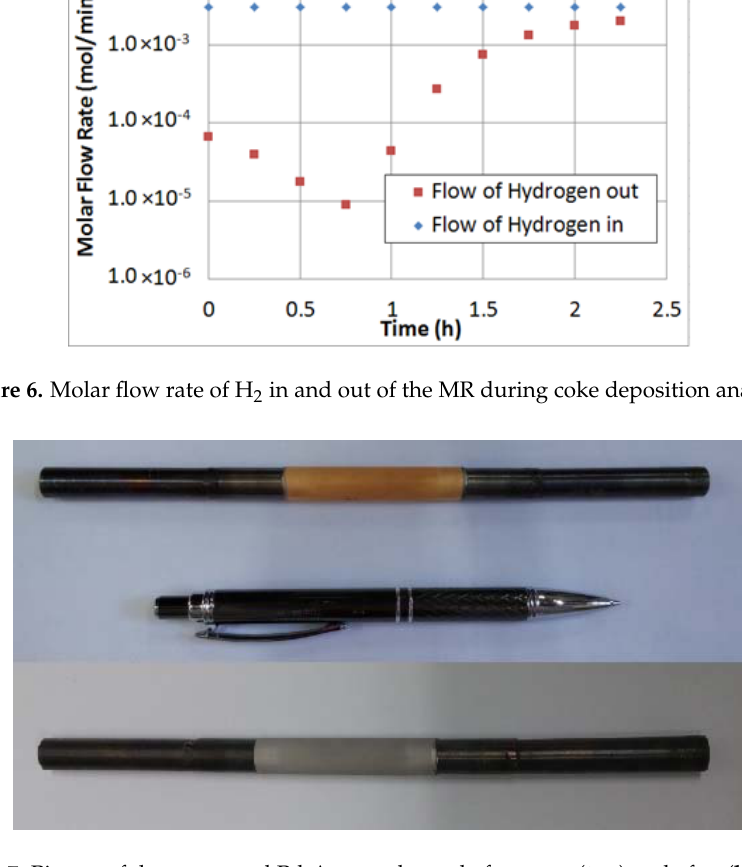
Figure 7. Picture of the supported Pd ‐ Au membrane before tests ( top ) and after ( bottom ).